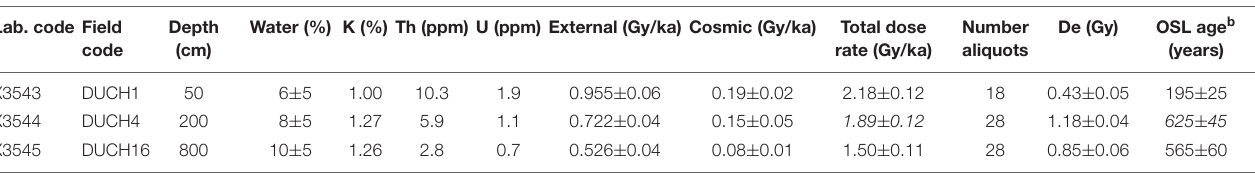
TABLE 2 | Summary of OSL dating and radioactivity